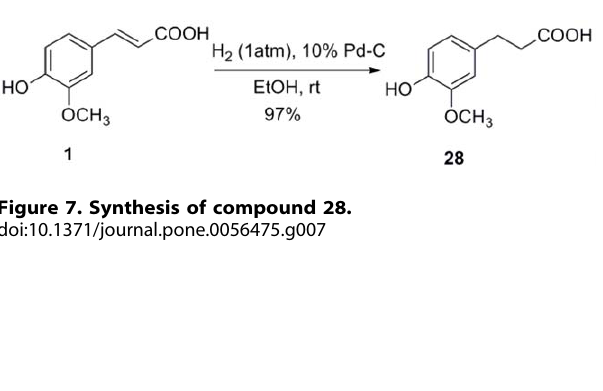
Table 1. In Vitro and In Vivo Anti-TMV Activity of Compounds 1 – 34 at 500 m g/mL.